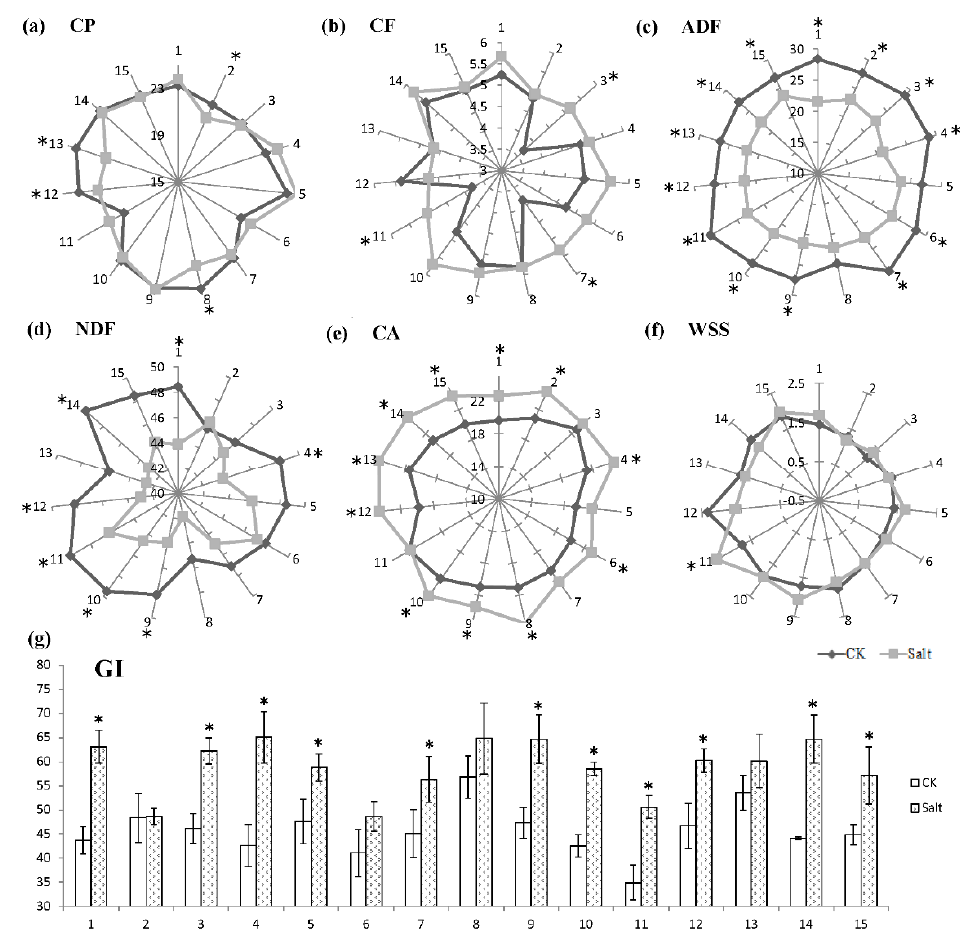
Figure 4. Effect of salt on the forage quality of Italian ryegrass; ( a ) crude protein (CP); ( b ) crude fat (CF); ( c ) acid detergent fiber (ADF); ( d ) neutral detergent fiber (NDF); ( e ) crude ash (CA); ( f ) water-soluble carbohydrate (WSS); and ( g ) grading index (GI). Error bars are ± standard deviation. Asterisk means significantly different between control (CK) and salt stress (Salt) at the 0.05 level. The numbers from 1 to 15 indicate cultivars Tetragold, Angus No. 1, Abundant, Splendor, Double Barrel, Chuangjiang No. 2, Chuangnong No. 1, Muyao, Harukaze, Gongniu, Chuangnong, Tegao, Dongmu 70, Doraian, and Big Boss, respectively.